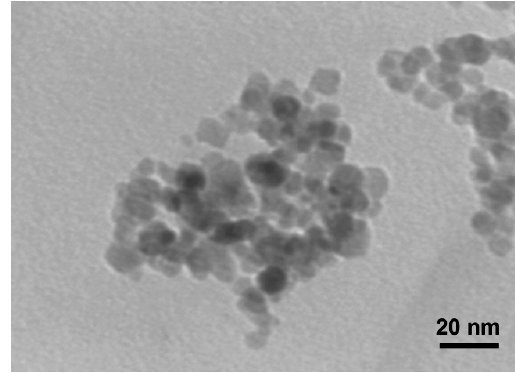
(b).Fig. 2. TEM image of oleic-acid-modified